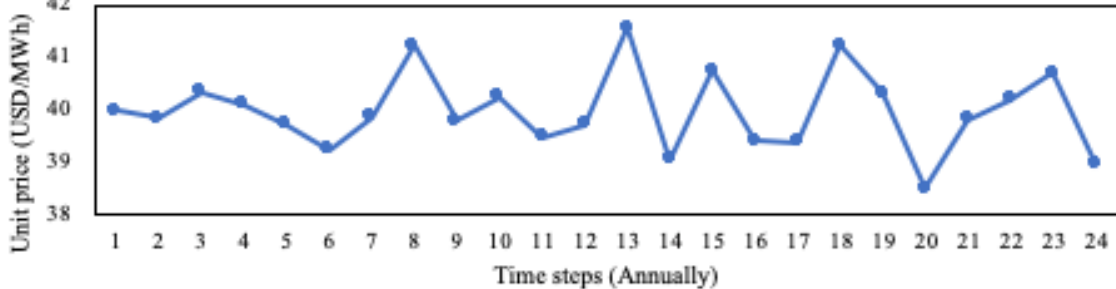
Figure 5. A single realisation of wholesale electricity price simulation.